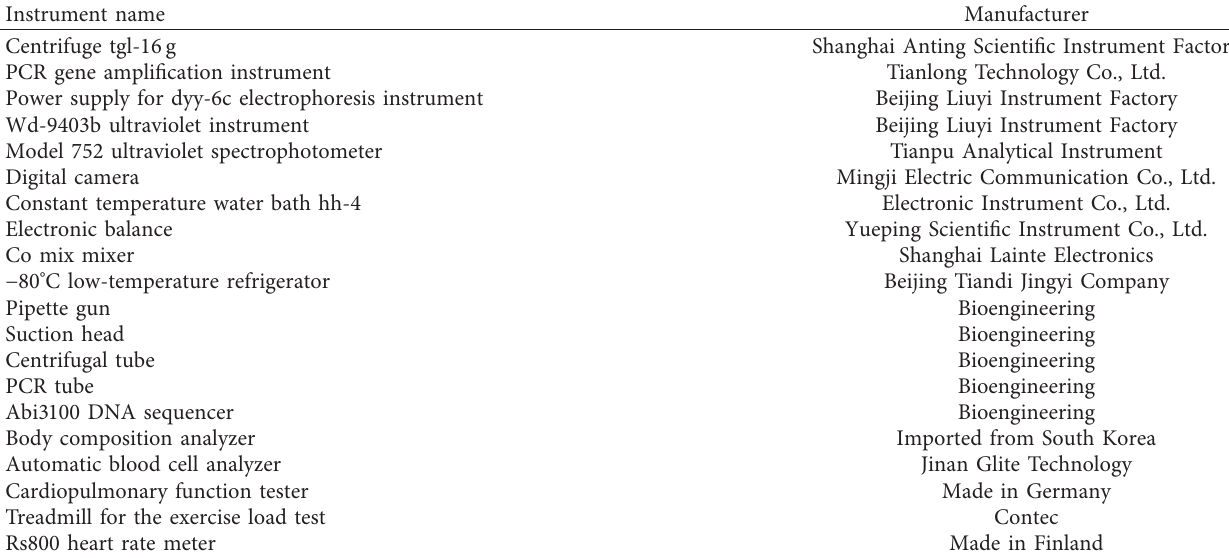
Table 1: List of the main experimental equipment.